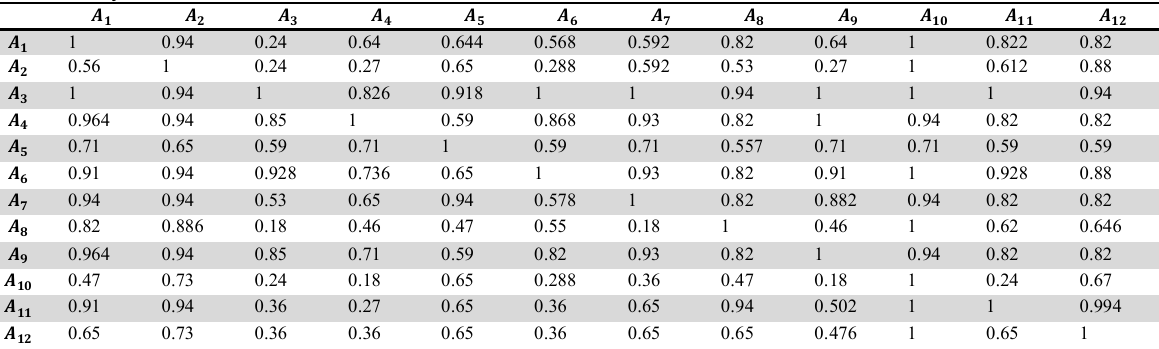
Credibility matrix